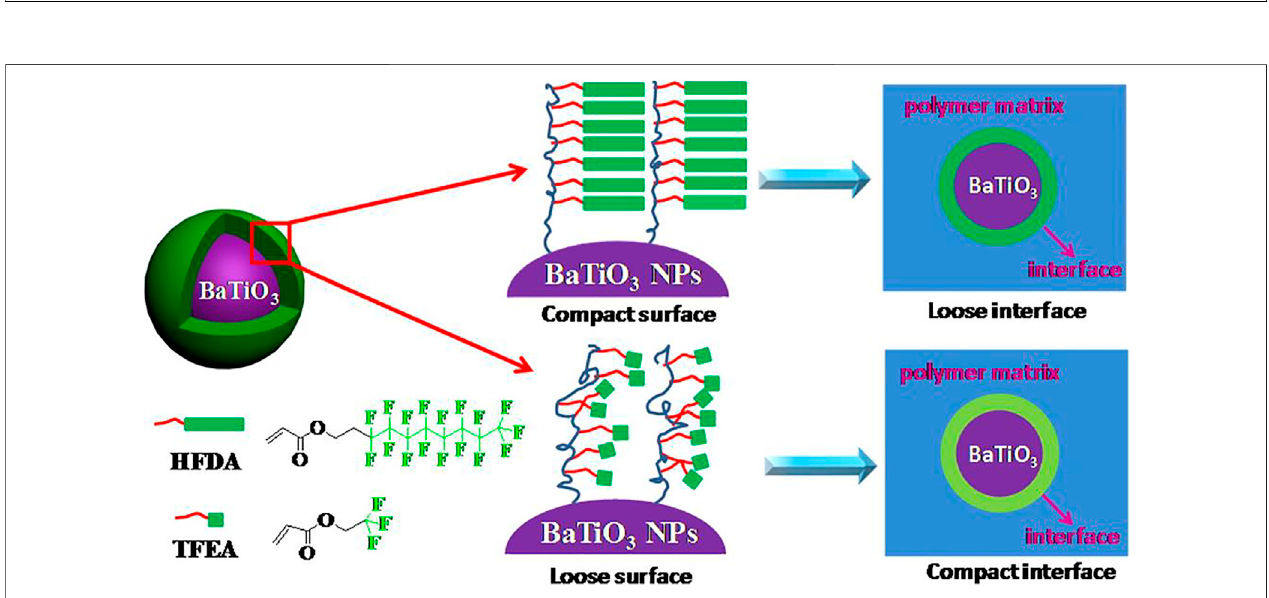
FIGURE 4 | Schematic illustration for the fl uoro-polymer@BT nanoparticles and the interfacial region within the nanocomposites. Reprinted with permission from Yang el al. (2013). Copyright© 2013 American Chemical Society.